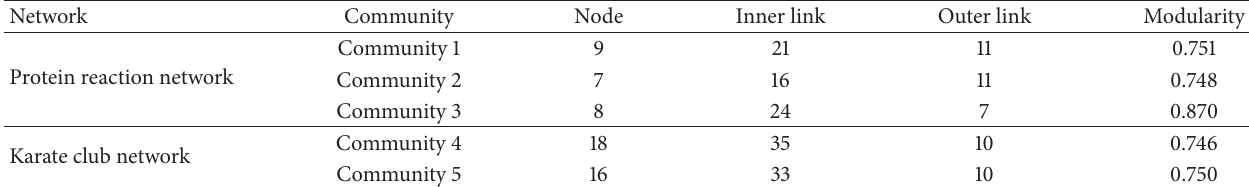
Table 1: The detailed communities information in networks.